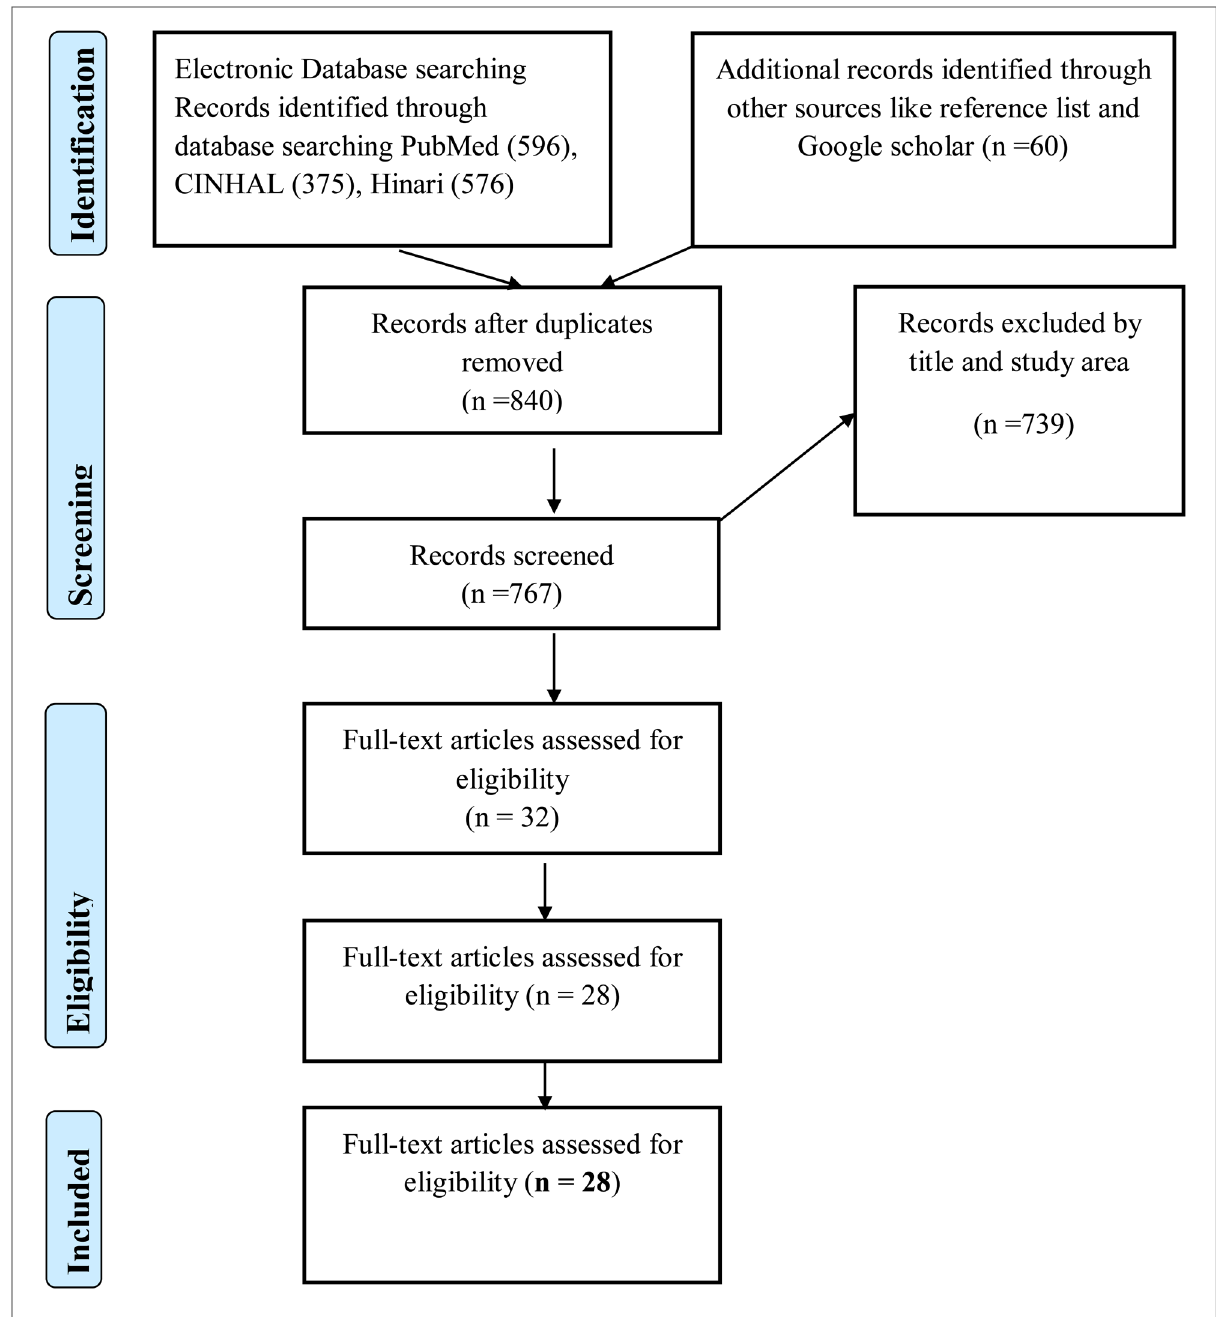
FIGURE 1 PRISMA fl ow chart diagram describing the selection of studies for the scoping review of postpartum family planning use among postpartum women in Ethiopia, 2021. PRISMA, Preferable Reporting Information in Systematic Review and